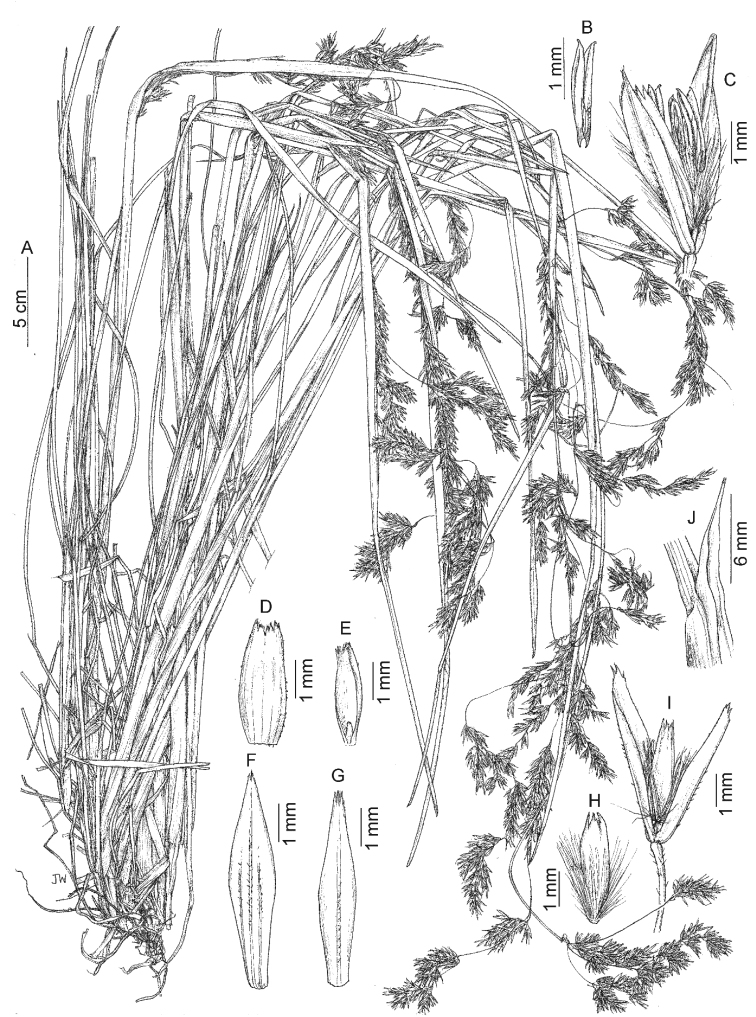
Deschampsiapodophoravar.mutica. A whole plant B anther C spikelet at maturity with anthers D lemma, abaxial view E palea, abaxial view F upper glume, abaxial view G lower glume, abaxial view H floret I spikelet and pedicel, lateral view J ligule; drawn by Juliet Beentje from the isotype, J.R.I. Wood 5033 (K).